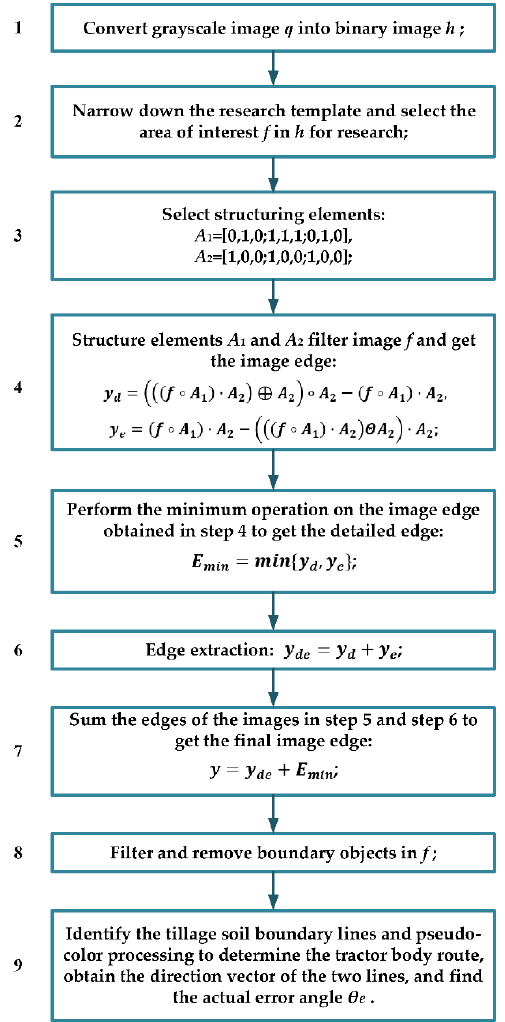
Figure 6. Improved anti-noise morphological algorithm.